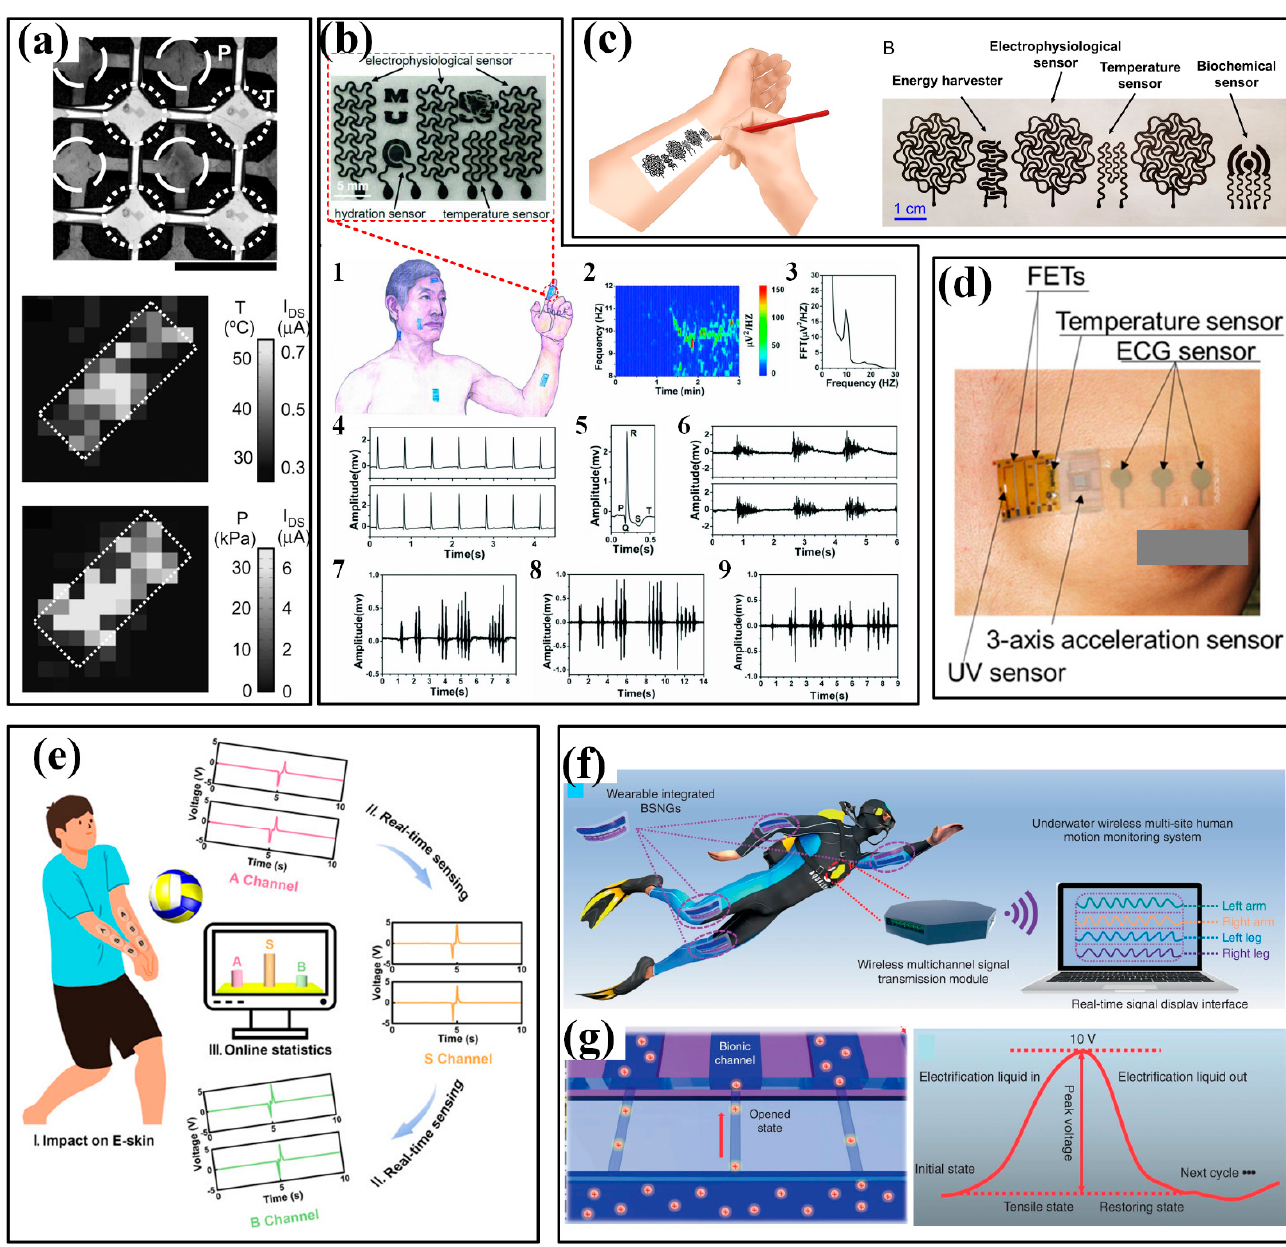
Figure 18. The wearable multifunctional sensors for sports: ( a ) the wearable pressure-temperature sensor and obtained distribution maps [181]; ( b ) the wearable device containing electrophysiological sensors, skin hydration sensors, temperature sensors/joule-heating elements and the obtained results of Alpha rhythm (2),center of Alpha rhythm (3), ECG signals (4), refined P,Q,T waves of ECG (5), EMG signals from the forearm (6) and EMG signals when the volunteer clenched the jaw (7), nodded the head (8), and bent a finger (9) [182]; ( c ) the pencil–paper on-skin multifunctional electronics [184]; ( d ) the multifunctional sensor for three-axis acceleration, ECG, temperature and UV [185]; ( e ) the TENG-based electronic skin to monitor the reception pressure in volleyball [188]; ( f ) the stretchable nanogenerator for underwater sensing and energy harvesting and ( g ) its working mechanism [189]. Reproduced with permissions from The National Academy of Sciences (2005) [181]. Reproduced with permissions from Wiley (2018) [182]. Reproduced with permissions from The National Academy of Sciences (2020) [184]. Reproduced with permissions from American Chemical Society (2021)